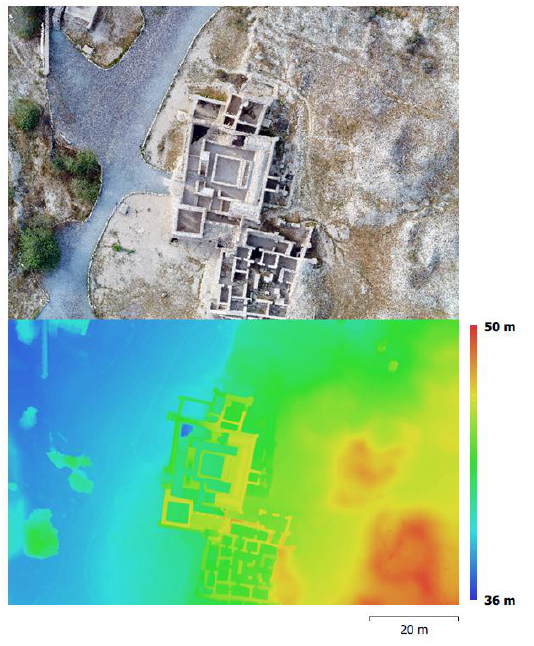
Figure 2. City of Harireh, Kish Island, Iran: Orthophoto (up), DSM